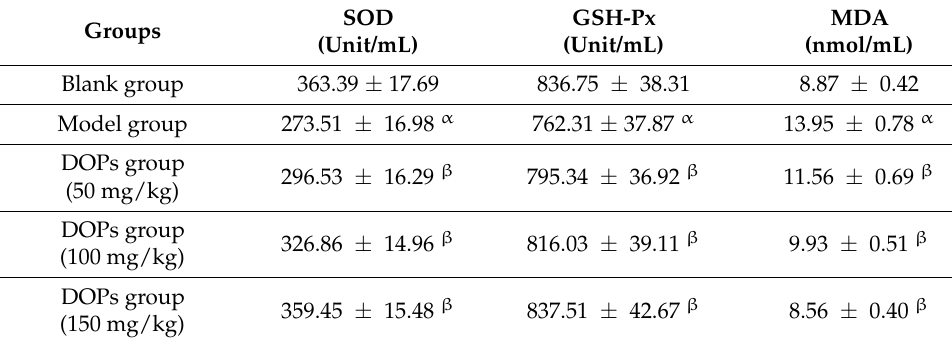
Table 4. Antioxidant enzymes activities and MDA contents of mice